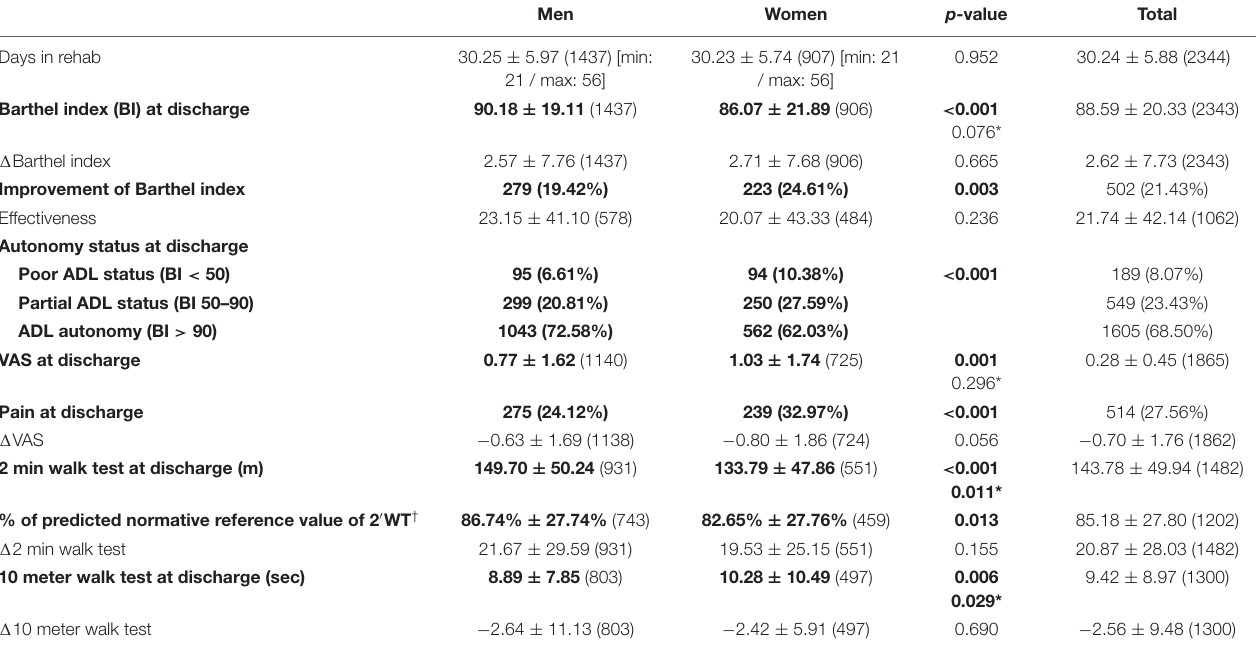
TABLE 2 | Stroke-related factors and functional outcomes of men and women at